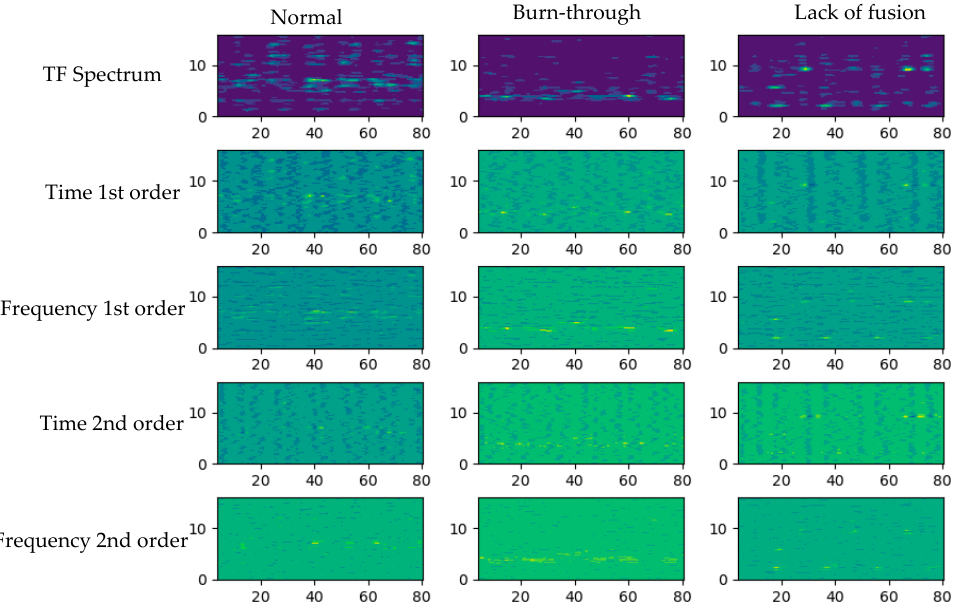
Figure 10. Time–frequency spectrum of different welding states and the difference.